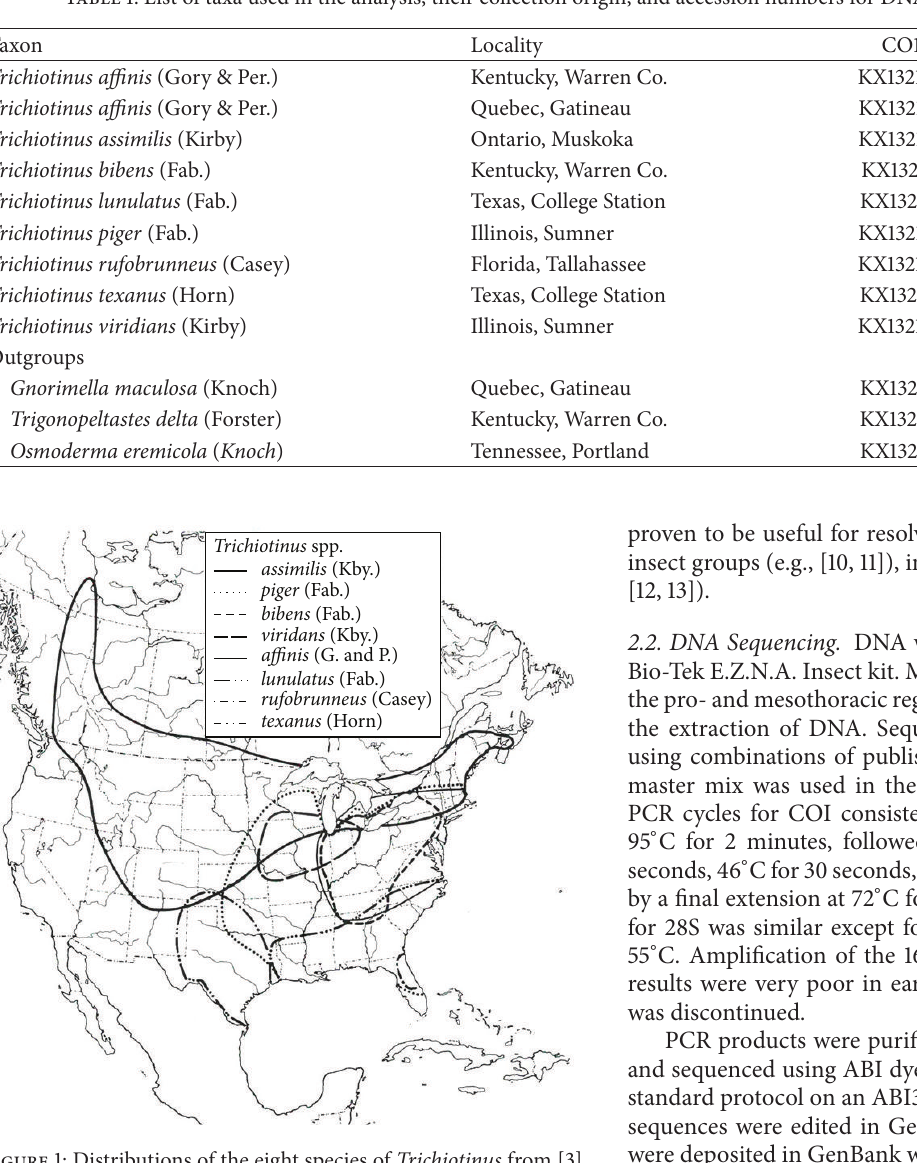
Figure 1: Distributions of the eight species of Trichiotinus from [3] (used with